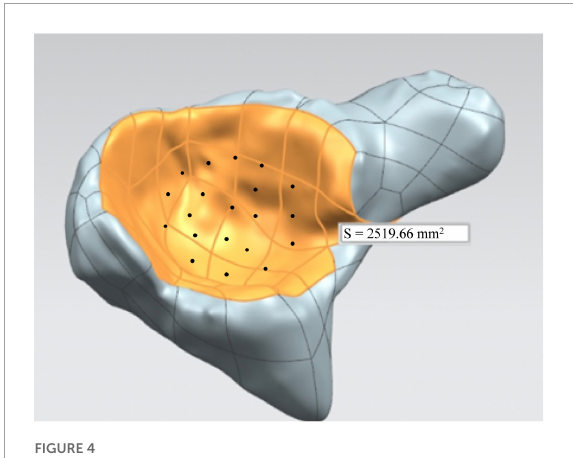
FIGURE4 Measurements of the area of acetabular inner surface and the radius of the acetabulum.